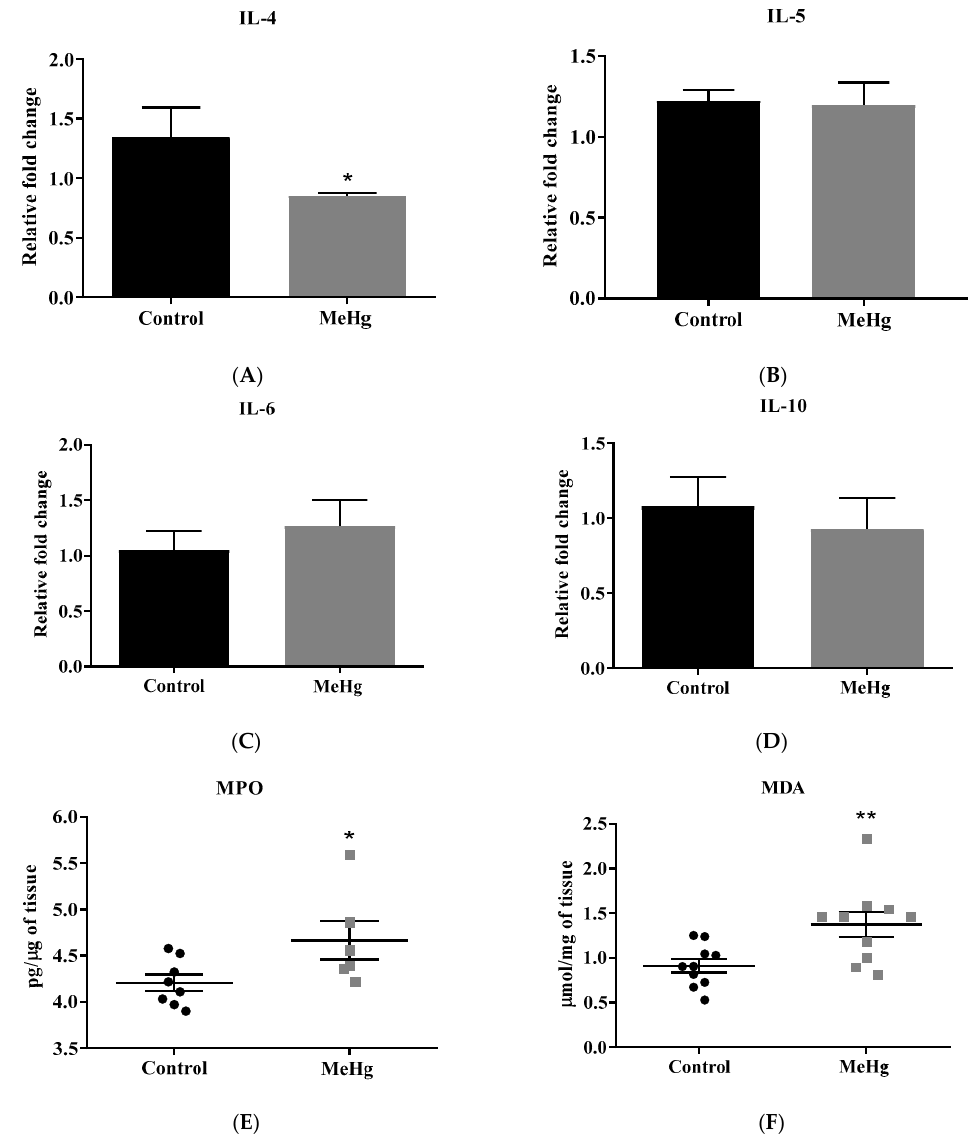
Figure 3. Hippocampal neuroinflammatory-related biomarkers. Values are expressed as mean ± SEM. ( A – D ) Neuroinflammatory-related gene expression in the hippocampus from MeHg-challenged mice. n = 6 per group, * p < 0.05 vs. control by the unpaired Student t -test. ( E ) Effect of the oral administration of MeHg (2 mg/L) over 30 days on the hippocampal MPO. n = 6 per group, * p < 0.05 vs. control by the unpaired Student T test ( F ) Effect of MeHg over 30 days on the hippocampal MDA concentration. n = 6 per group, ** p < 0.005 vs. control by the unpaired Student t -test. 2.4. Hippocampal Neurochemical Changes Chronic MeHg intoxication induced higher levels of GABA (MeHg: 14,005 ± 3554; Control: 3402 ± 859.7, p = 0.01) (Figure 4A) and glycine (MeHg: 3437 ± 1884; Control: 421.1